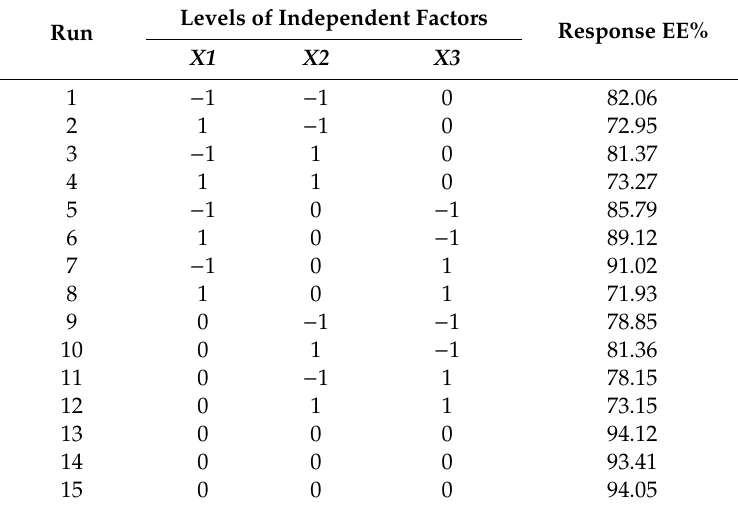
Table 1. The experimental conditions and the corresponding results.